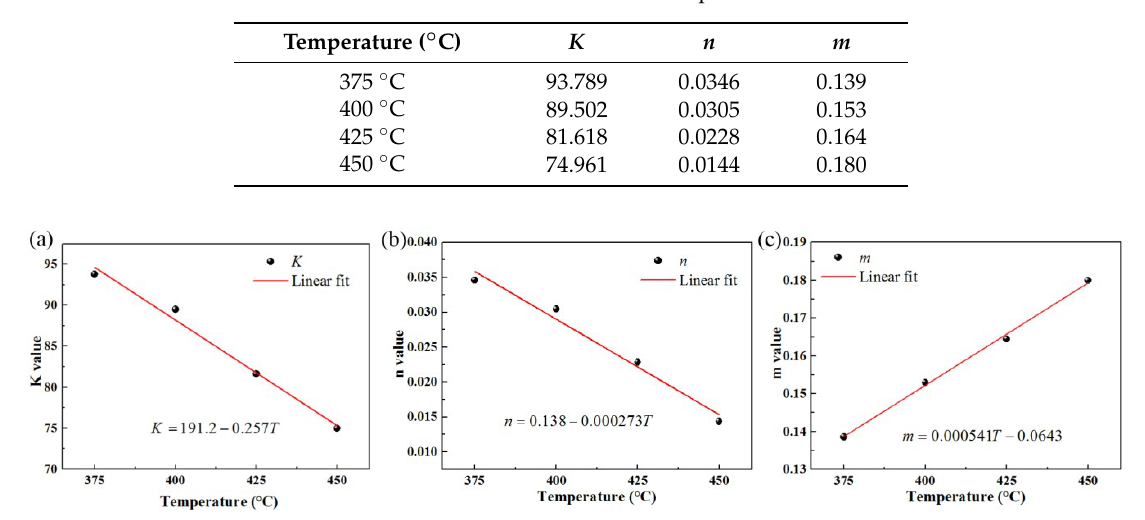
Figure 8. The relationships between the parameters: ( a ) T–K ; ( b ) T–n ; ( c ) T–m .